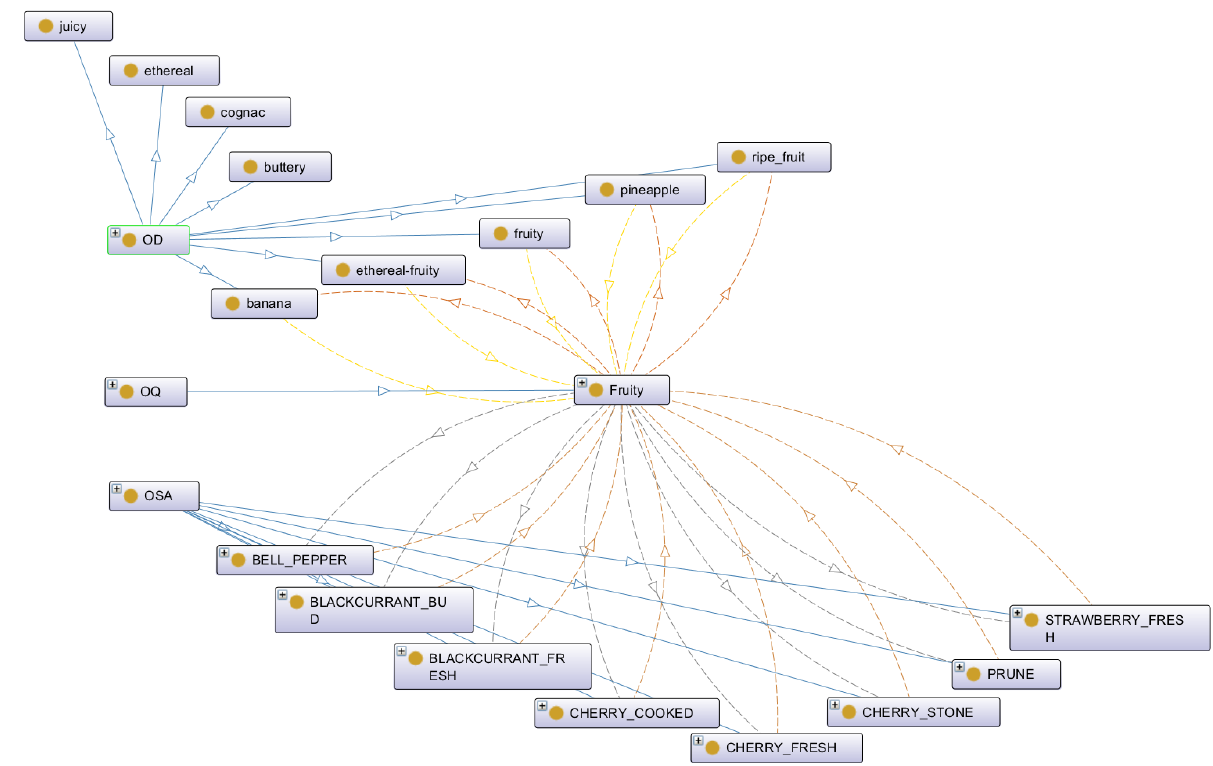
Figure 3. Properties and relationships among the classes OD, OQ, and OSA, considering the OD of the odorant Ethyl butanoate.